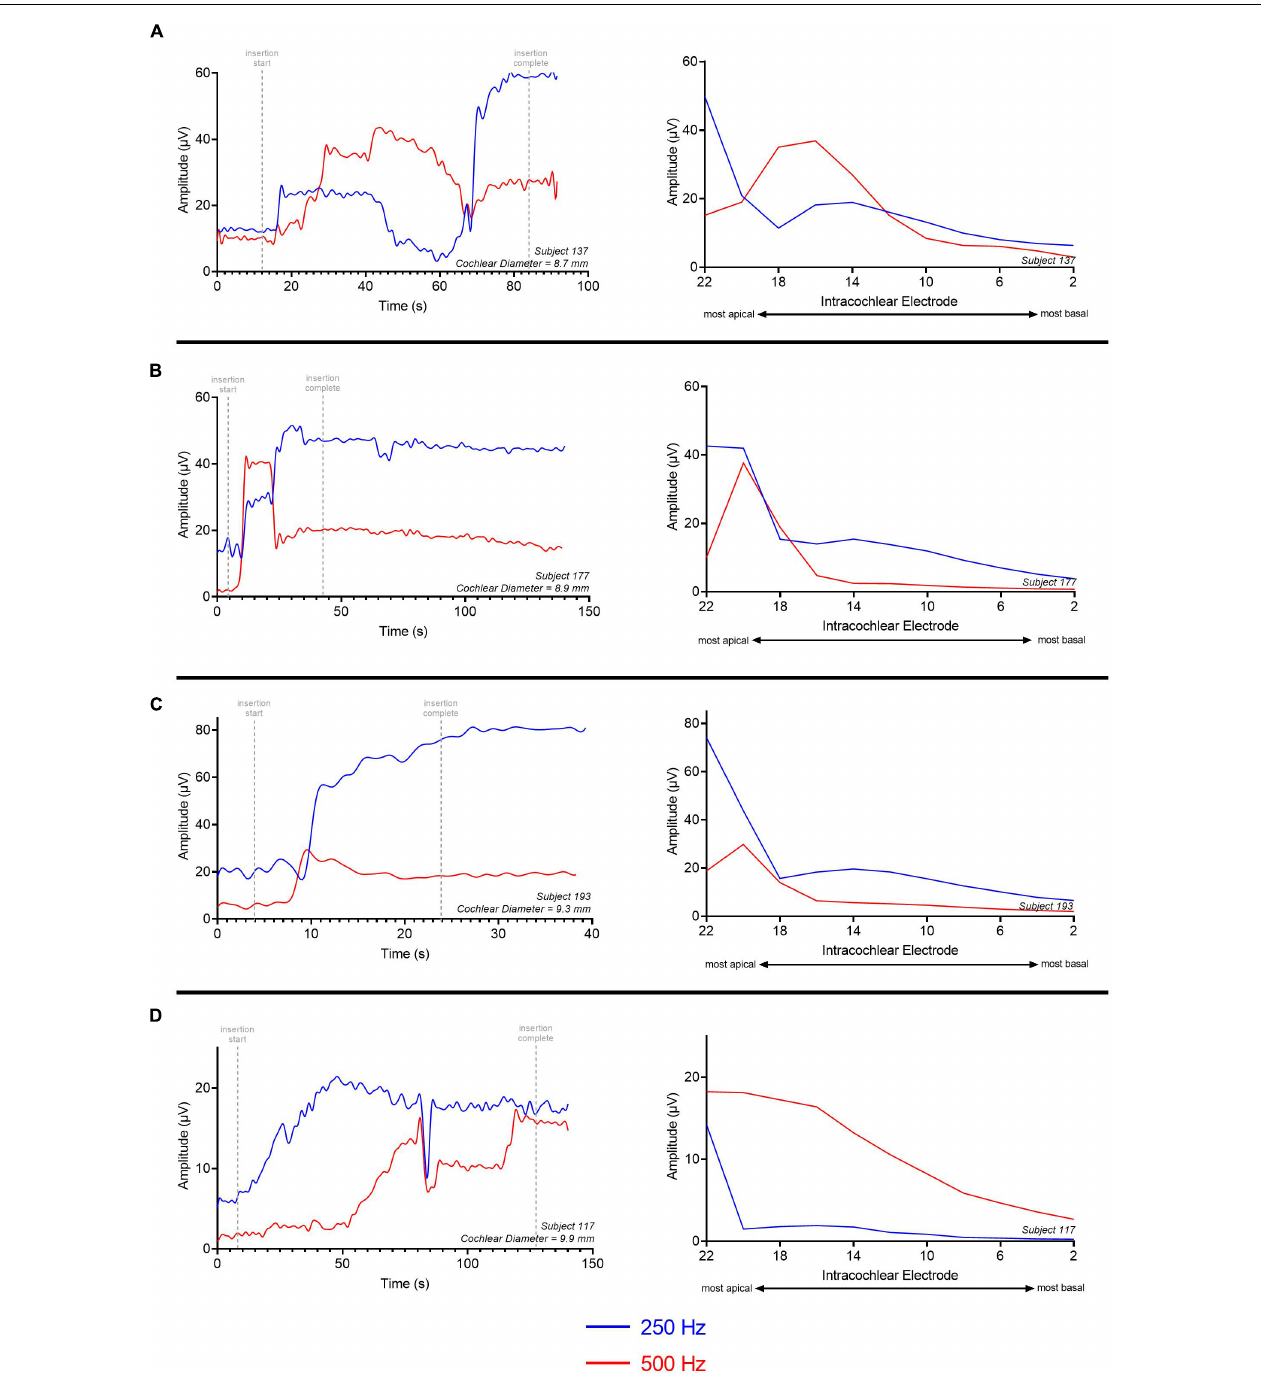
FIGURE 8 | Multifrequency ECochG with 250- and 500-Hz acoustic stimulus is measured during the insertion of the electrode array. Responses were measured across the electrode array with independent presentations of 250 (red) and 500-Hz (blue) after full insertion (electrode sweep). The cochlear diameter across these examples increases in length from (A–D) . (A) There is a gradual rise in ECochG response for both 250- and 500-Hz acoustic stimulus; however, the 500-Hz ECochG response continues to drop during insertion of the last 4–6 electrodes while the 250-Hz ECochG response continues to rise. The electrode sweep shows a maximum ECochG response at electrode 16 and electrode 22 for 500 and 250-Hz, respectively. (B,C) Gradual rise in ECochG response for 250- and 500-Hz with a drop in 500-Hz response during insertion of last 2–4 electrodes. Electrode sweep shows a maximum ECochG response at electrode 20 and electrode 22 for 500 and 250-Hz, respectively. (D) Gradual rise in ECochG response for both 250- and 500-Hz acoustic stimulus throughout the insertion with congruent drop across 250- and 500-Hz. Electrode sweep shows a maximum ECochG response at electrode 22 for both 250- and 500-Hz acoustic stimulus. This example was a patient with a large cochlea (cochlear diameter from RW to modiolus = 9.9 mm) as measured from 3-D reconstructions of postoperative temporal bone imaging.